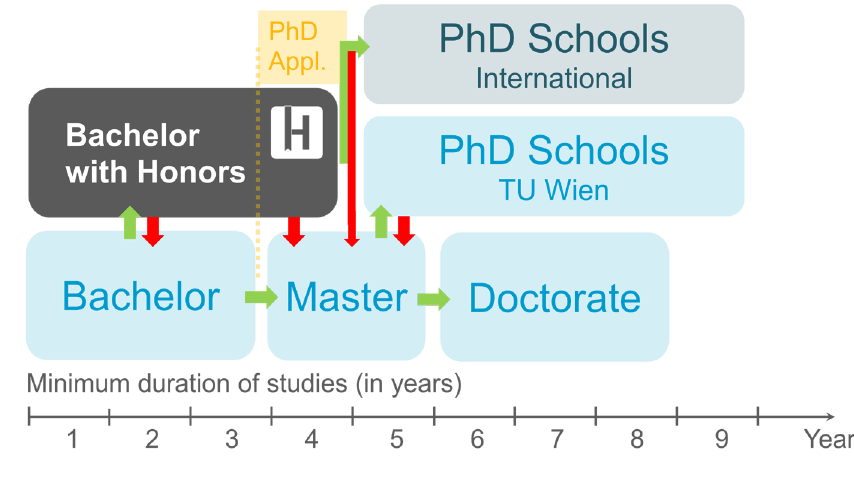
Figure 1. Positioning of Bachelor with Honors